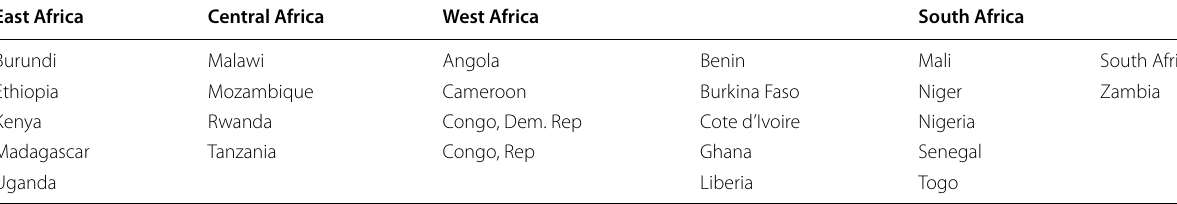
Table 4 List of countries in the sample East